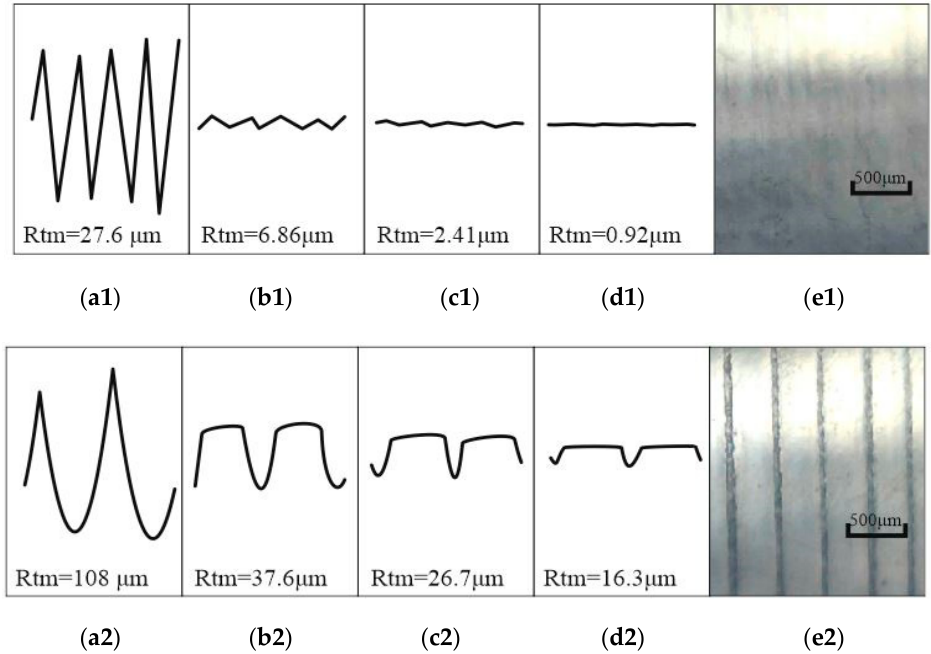
Figure 9. Schematic representation of a microprofileof the steel 45 surface after turning ( a ), after1 ( b ), 2 ( c ), 3 ( d ) passes of the deforming element and a photograph of the surface after treatment ( e